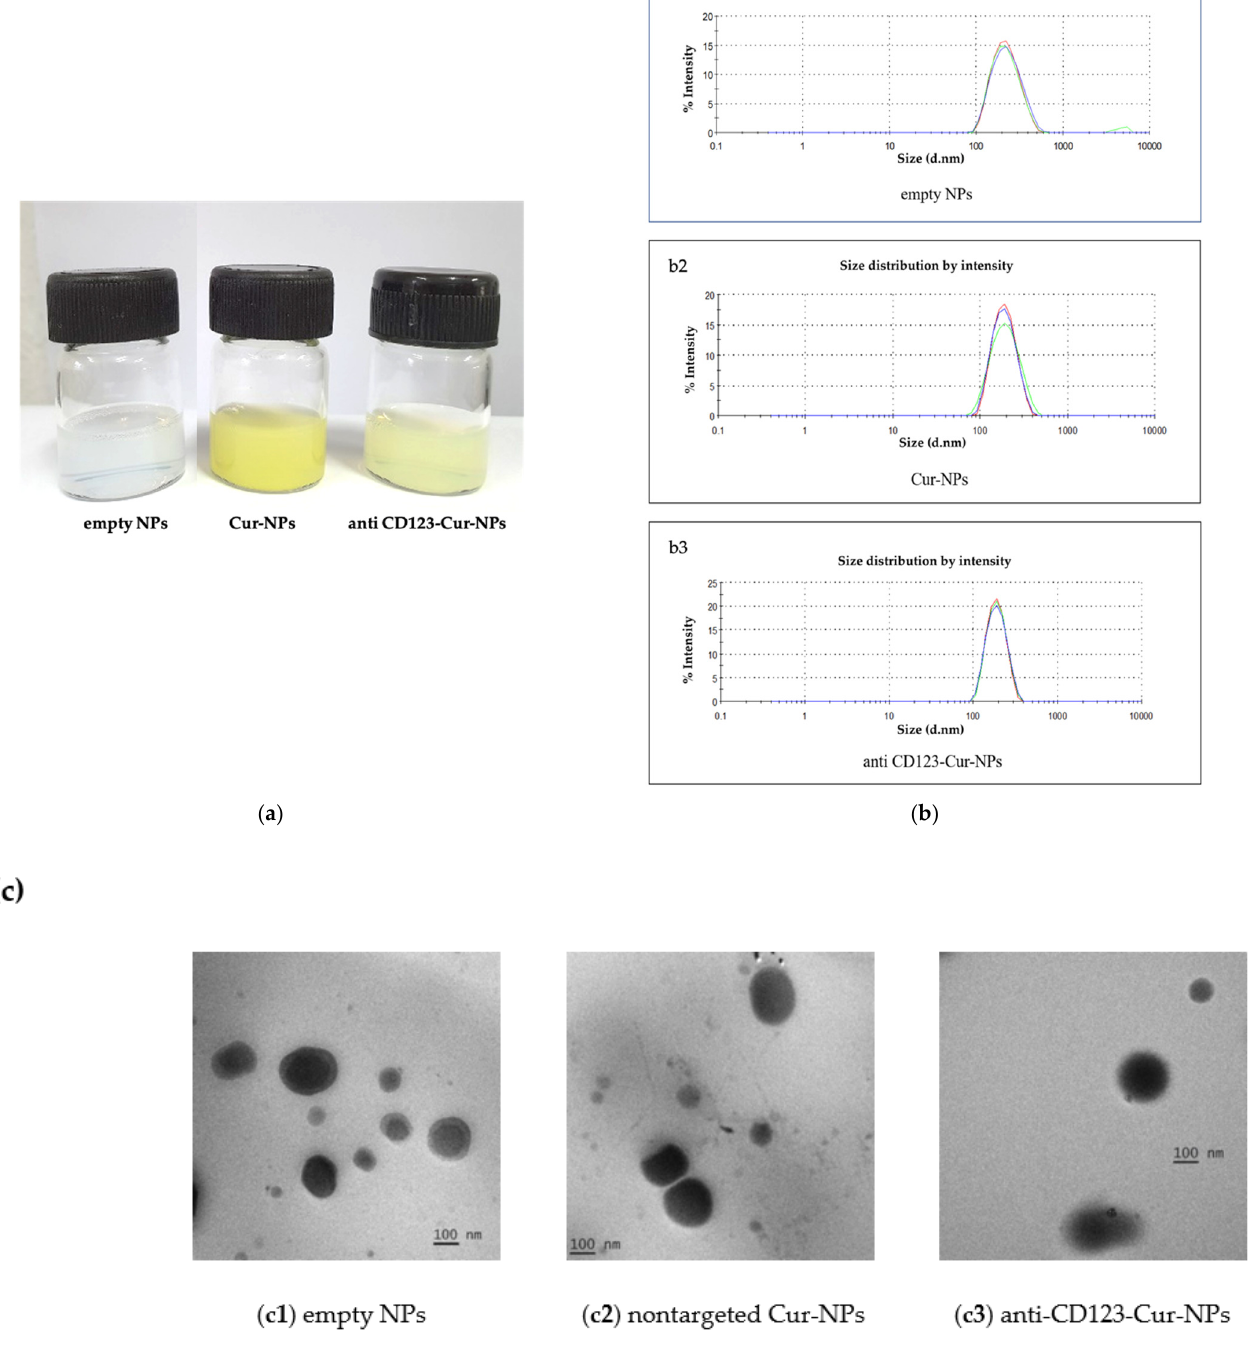
Figure 2. Characterization of nanoparticles. ( a ) Color of empty NPs, Cur-NPs, and anti-CD123-Cur-NPs. ( b ) Size measure- ment of the nanoparticles using dynamic light scattering (DLS); ( b1 ) empty NPs, ( b2 ) Cur-NPs, and ( b3 ) anti-CD123-Cur-NPs. ( c ) TEM image of ( c1 ) empty NPs, ( c2 ) nontargeted Cur-NPs, and ( c3 ) anti-CD123-Cur-NPs.